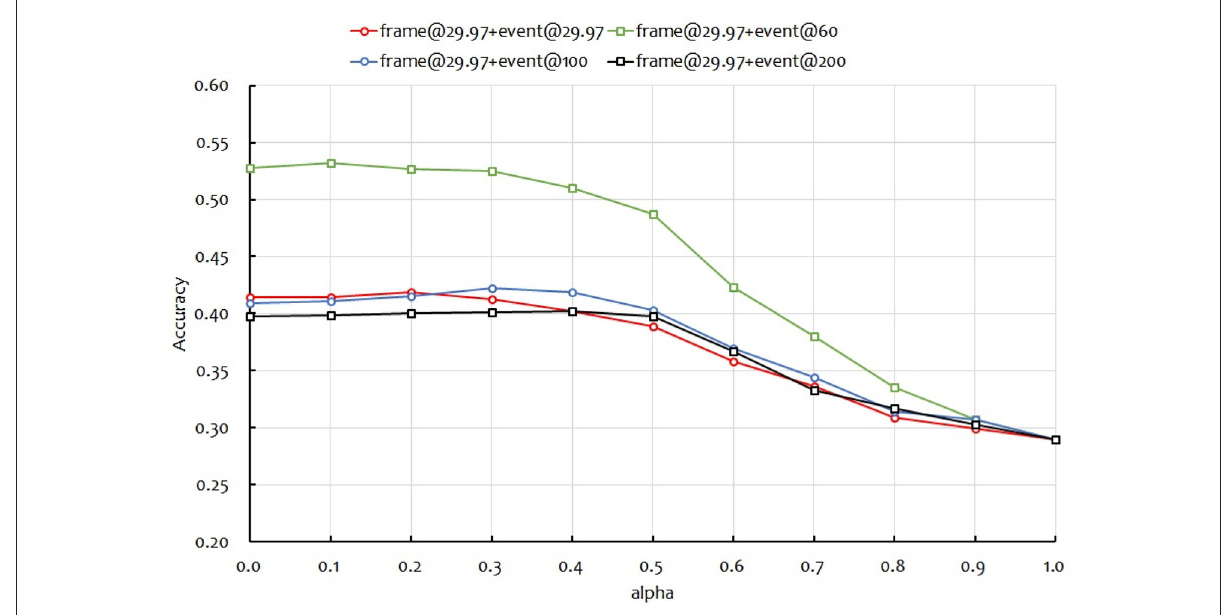
FIGURE9 Recognition accuracies against α .